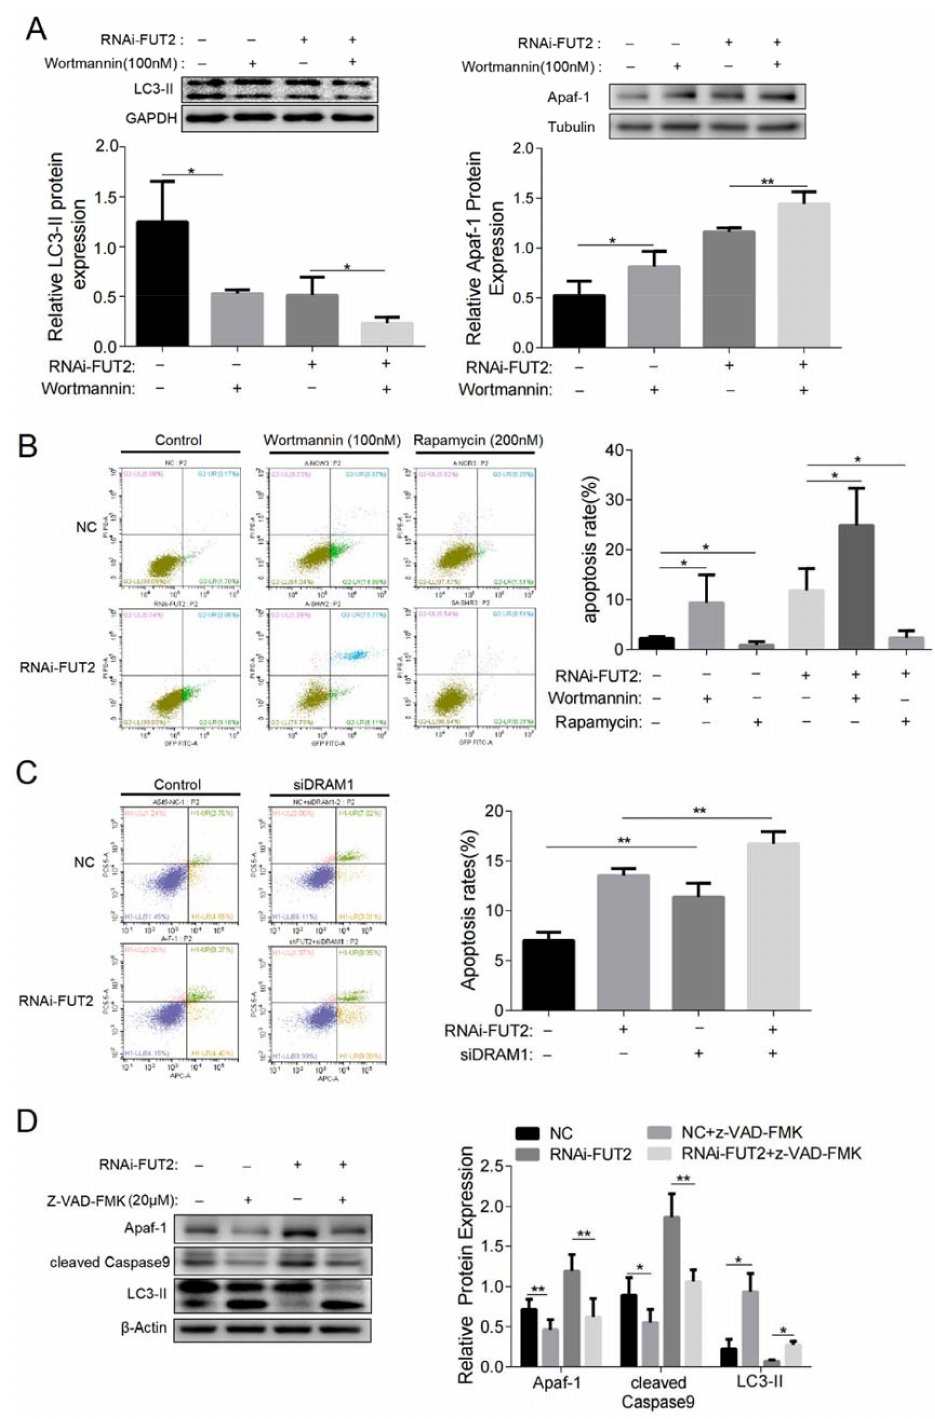
Figure 7. The regulation of autophagy and apoptosis by FUT2 and their antagonism in LUAD cells. ( A ) Representative Western blot showing the expressions of LC3-II and Apaf-1 in FUT2-knockdown A549 cells or control cells in the presence or absence of wortmannin. ( B ) Flow cytometry was used to analyze the apoptosis rate in FUT2-knockdown A549 cells or control cells in the presence or absence of wortmannin or rapamycin. ( C ) Flow cytometry was used to analyze the apoptosis rate in FUT2- knockdown A549 cells or control cells in the presence or absence of siDRAM1. ( D ) Representative Western blot showing the expressions of Apaf-1, cleaved caspase 9, and LC3-II in FUT2-knockdown A549 cells or control cells in the presence or absence of z-VAD-FMK. (* p < 0.05, and ** p <